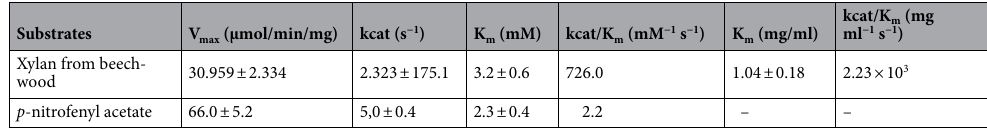
Table 1. Kinetic parameter values calculated for XylR. The values are represented as the mean ± standard deviation.